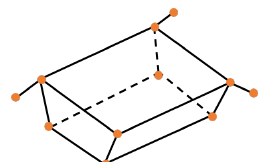
Figure 6. The reconstructed 3D wireframe model with 11